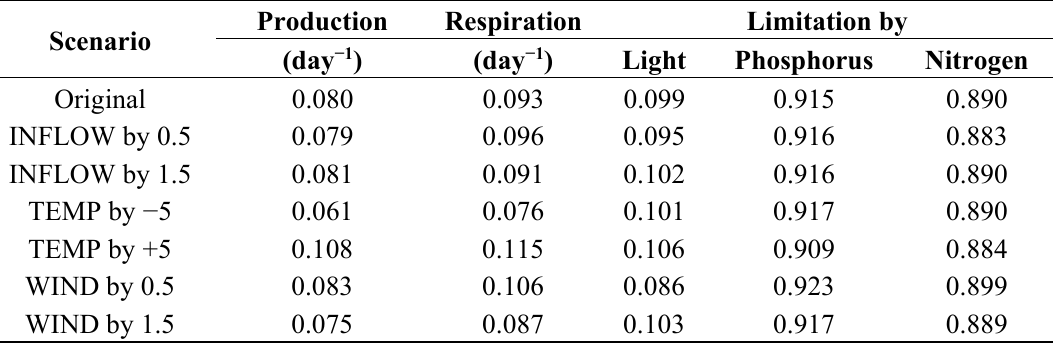
Table 4. Mean cyanobacterial growth characteristics in ELCOM-CAEDYM